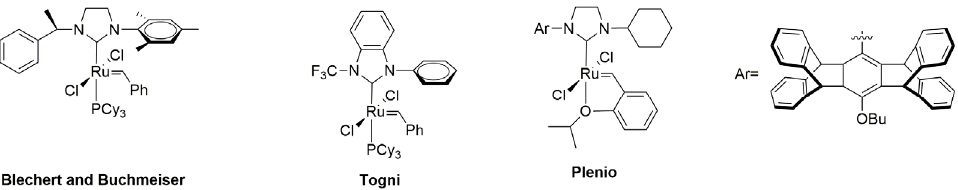
Figure 1. Grubbs- and Hoveyda–Grubbs-type catalysts with uNHCs for alternating ROMP copolymerization.